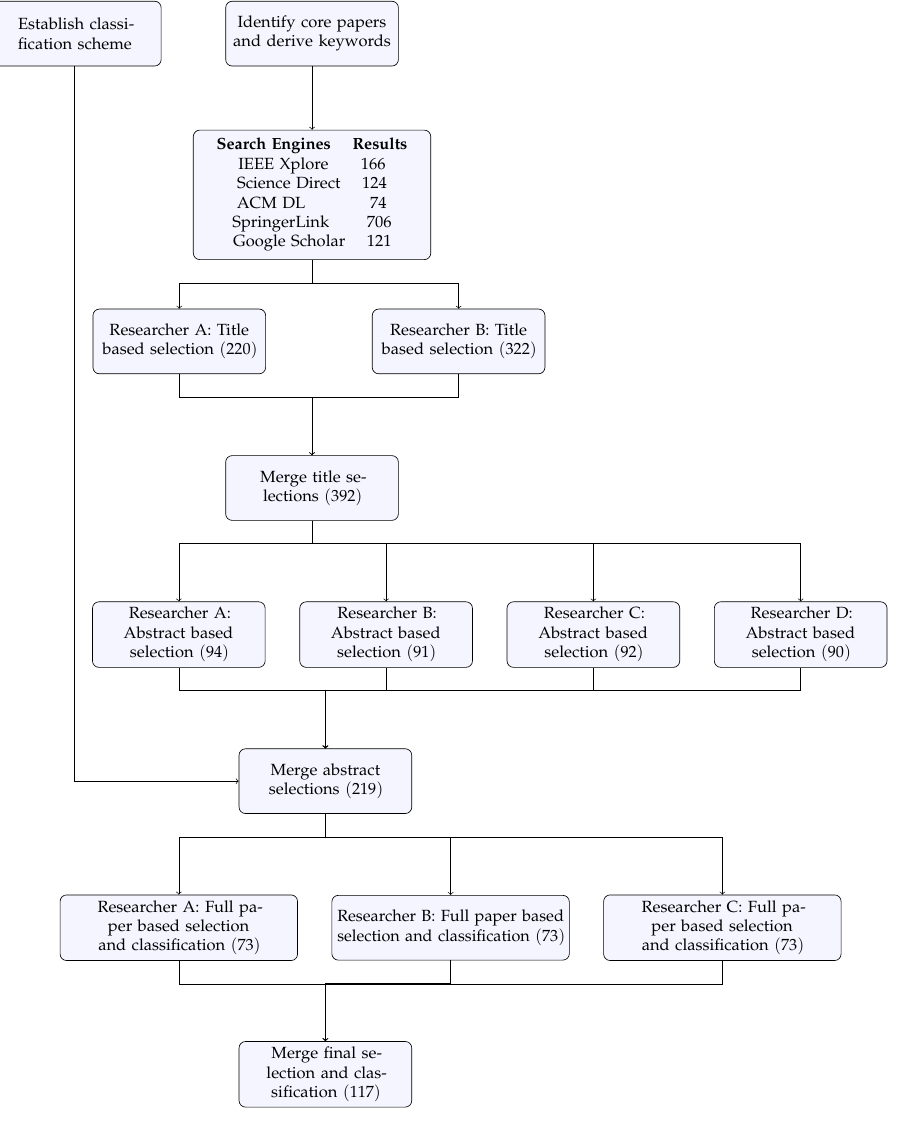
Figure 1. Mapping study flow